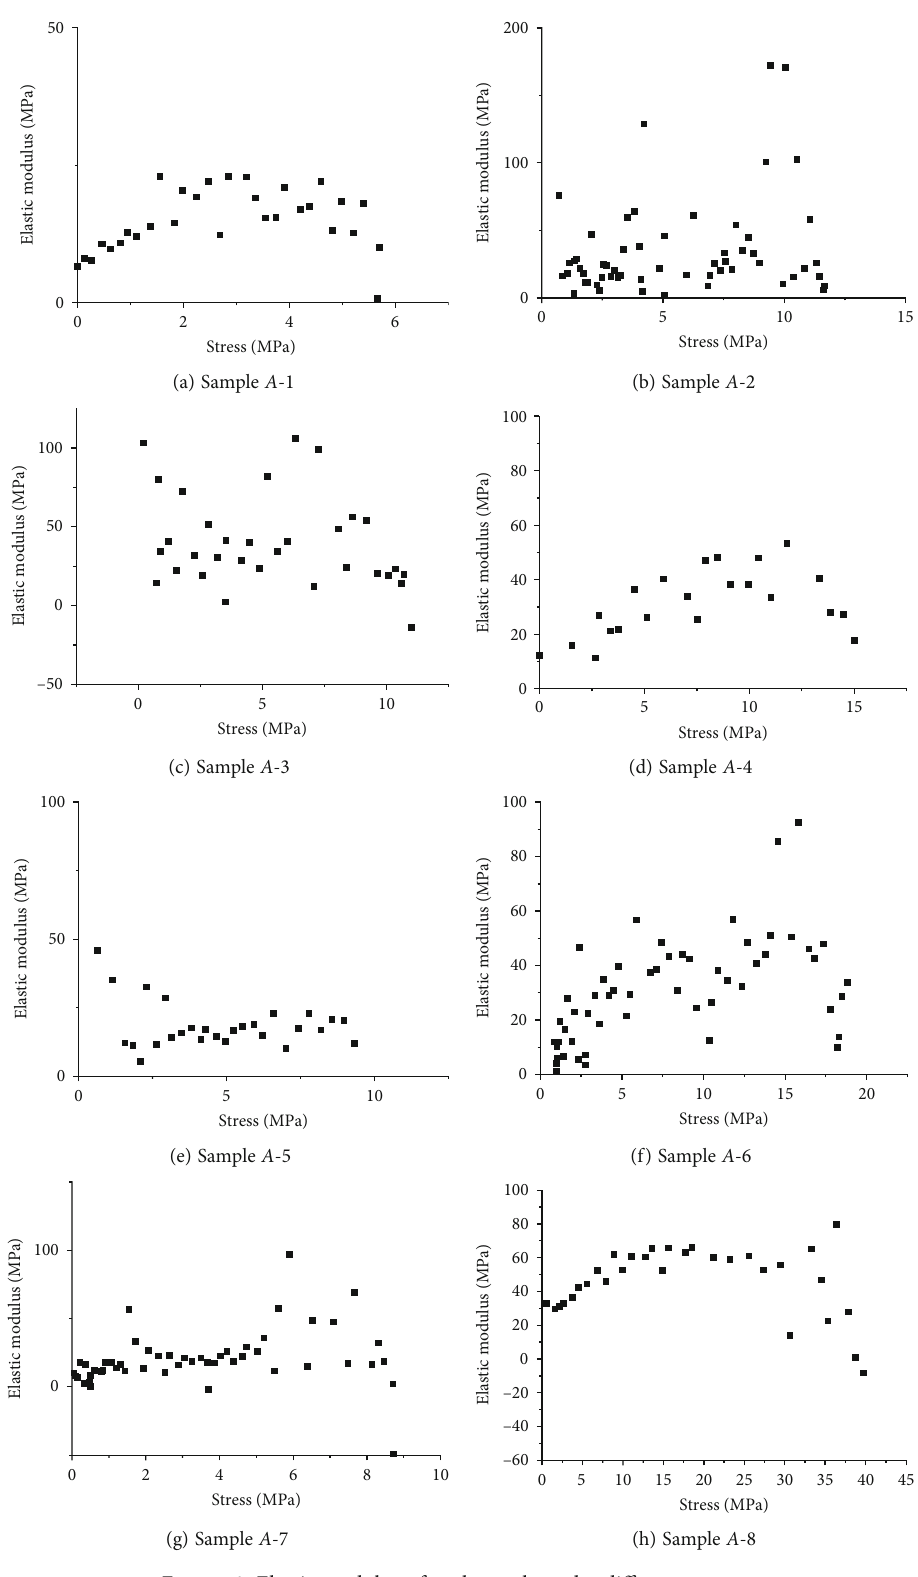
Figure 3: Elastic modulus of coal sample under di ff erent